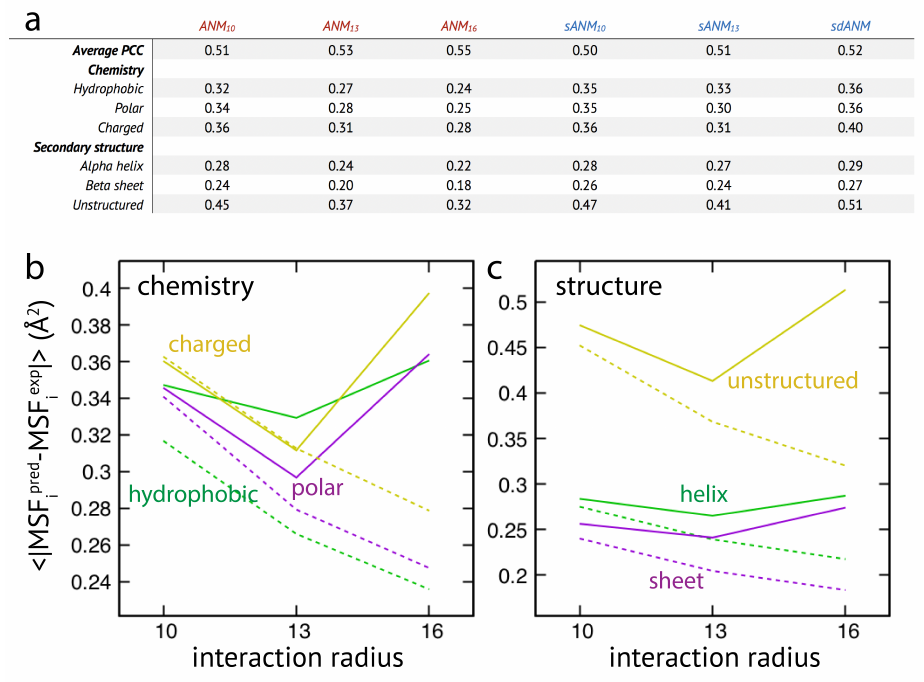
Figure 3. Extensive analysis of predictions by ENM variants. ( a ) The correlation coefficient averaged over all considered structures is shown for all models (top row). The averaged absolute deviation in MSF predictions for residue beads from groups with different chemical specificity (hydrophobic, polar, and charged) is shown for all models. Also shown is the averaged absolute error for residue beads categorized into different secondary structural elements. In ( b , c ), corresponding graphs are shown. Solid lines correspond to sANM data, where values for sdANM are displayed at interaction radius abscissa position 16 Å. Dashed lines are used for ANM